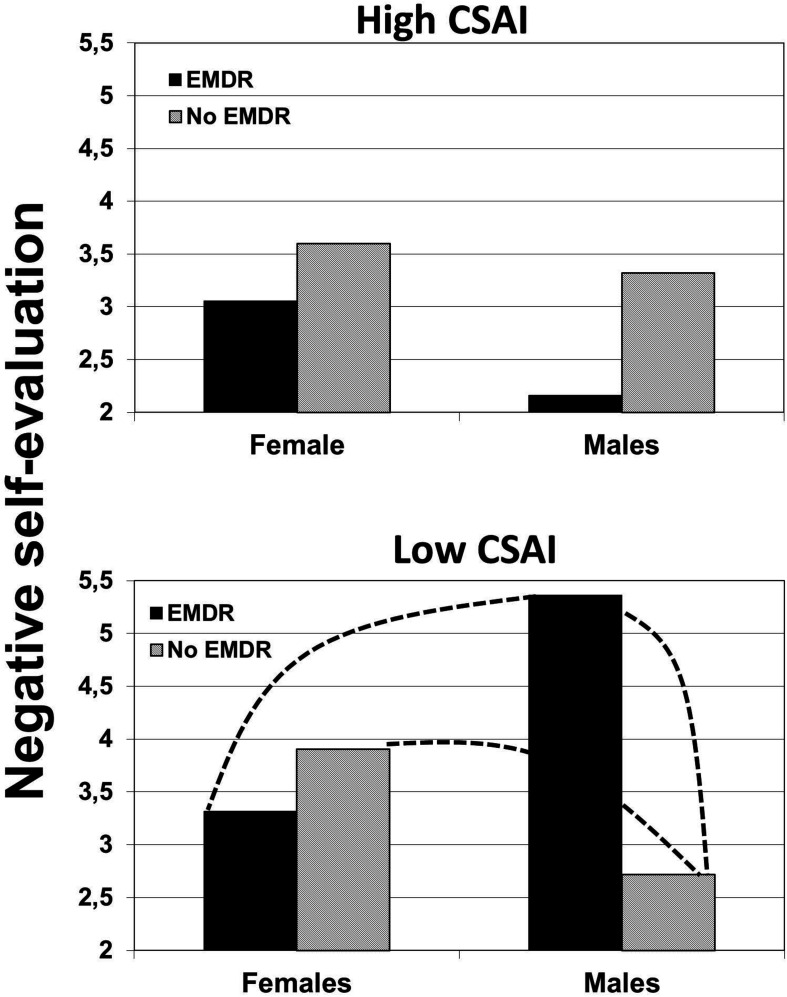
The effects of induced eye movements (EMi) on negative self-evaluation, moderated by CSAI and gender (the dotted line indicates a significant difference).